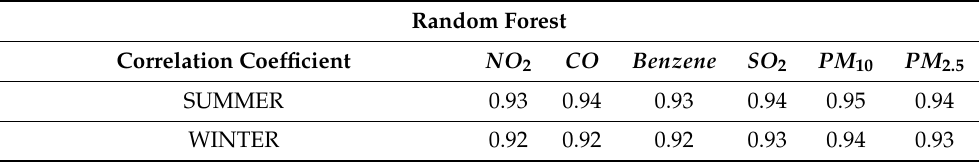
Table 6. Correlation coefficients for all air quality features for both the summer and winter seasons for the non-linear